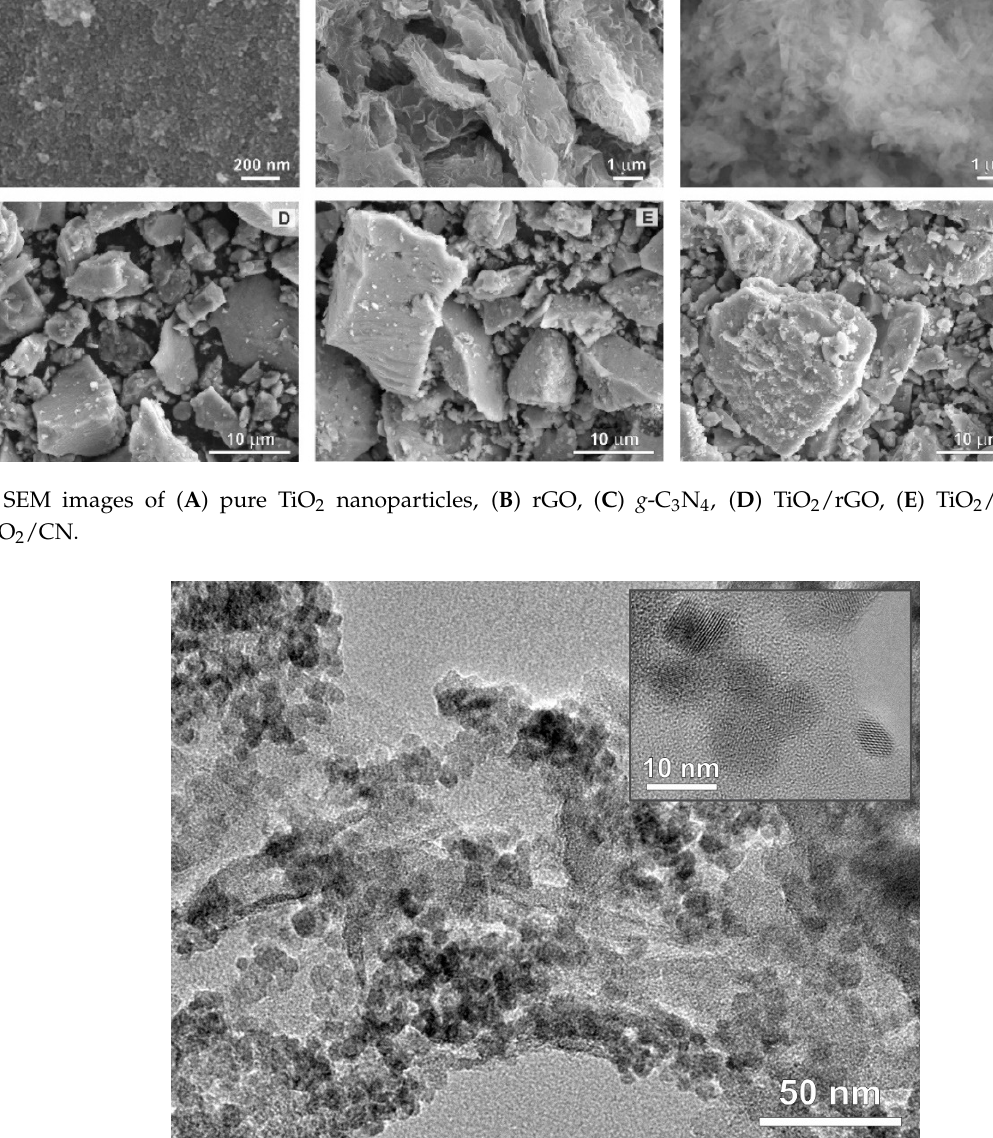
Figure 4. TEM image of rGO@TiO 2 /CN nanocomposite and inset of anatase TiO 2 nanoparticles.